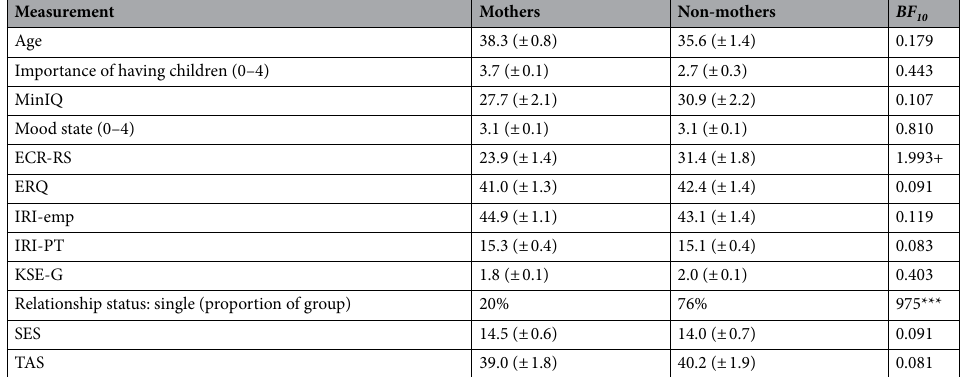
Table 1. Mean, standard error and corrected Bayes factor for all Bayesian Mann–Whitney-U tests performed on answers from the interview and scores from the questionnaires. The proportion of single women per group and Bayes factor of the contingency table. ECR-RS relationship attachment, ERQ emotion regulation quotient, IRI interpersonal reactivity, emp empathy, PT perspective taking, KSE-G tendency for social desirability, SES socioeconomic score, TAS alexithymia score; + signifies anecdotal evidence, ***signifies decisive evidence (according to Jeffrey’s scheme 56 ).